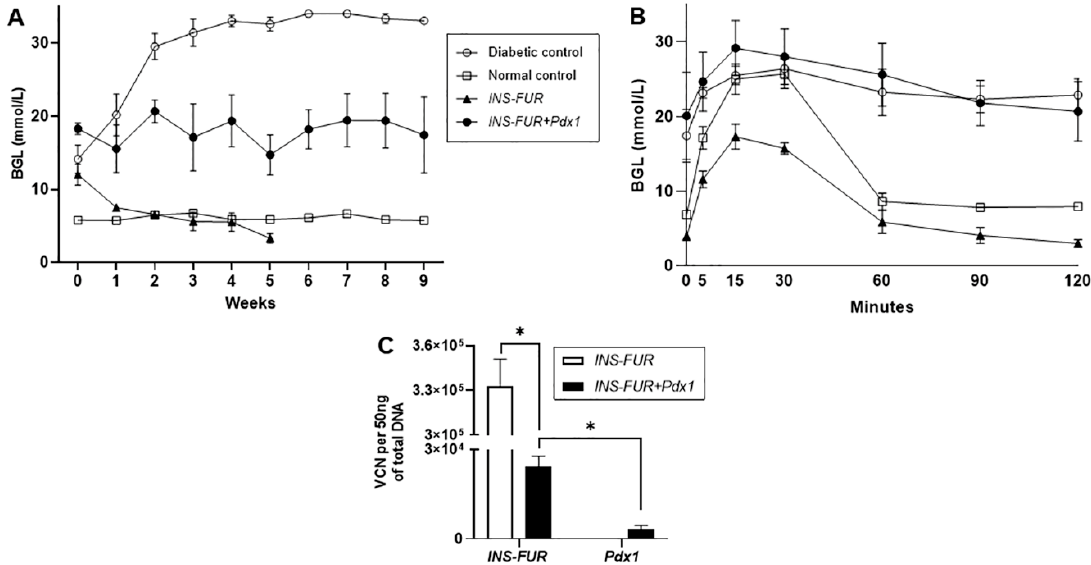
Figure 2. Blood glucose levels, IPGTTs and AAV8 VCNs of NOD mice after expression of INS-FUR alone, or with Pdx1 , using the AAV8 vector. Transduction of NOD mice with AAV8- INS-FUR or AAV8- INS-FUR + AAV8- Pdx1 did not reverse hyperglycaemia in diabetic mice . ( A ) The mean weekly blood glucose levels of diabetic (n = 7), normal (non-diabetic) (n = 7) and treated diabetic mice that received i.p. injections of either AAV8- INS-FUR -mCherry (n = 4), or AAV8- INS-FUR -venus + AAV8- Pdx1 (n = 5) are shown. ( B ) Blood glucose levels following an IPGTT of diabetic (n = 3), non-diabetic (n = 7) and treated diabetic mice that received i.p. injections of either AAV8- INS-FUR -mCherry (n = 3) or AAV8- INS-FUR -venus + AAV8- Pdx1 (n = 4). ( C ) AAV8 vector copy numbers of the diabetic mice transduced by AAV8-INSFUR-mCherry (n = 4) or AAV8-INSFUR-venus + AAV8- Pdx1 (n = 5). Results are expressed as the means ± SEMs. * indicates a significant difference of p < 0.05 when comparing the VCNs.